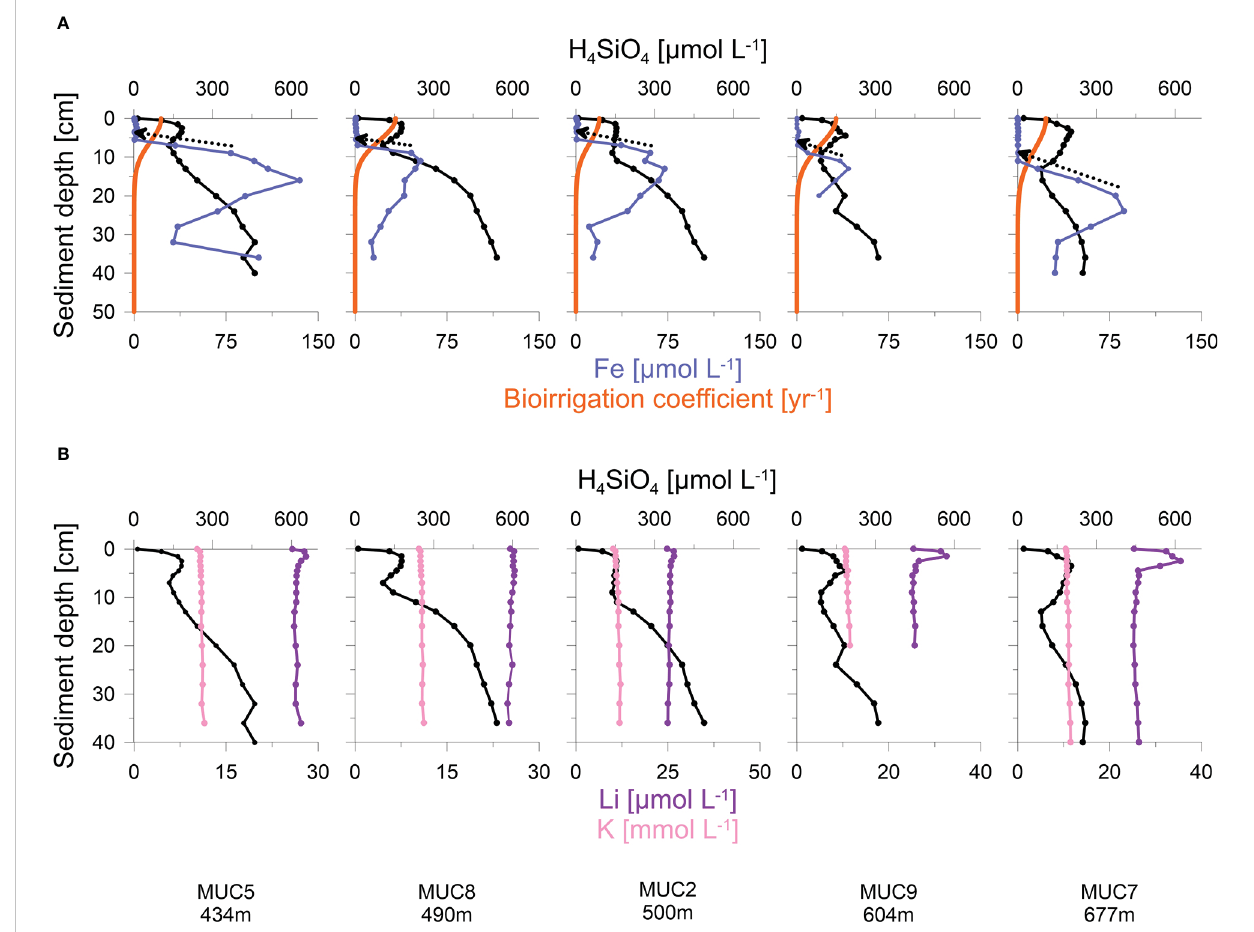
FIGURE 4 (A) Porewater concentrations of H 4 SiO 4 , total dissolved Fe and model simulations of bioirrigation (orange curves). Dashed arrows indicate the gradient used to calculate diffusive Fe fl uxes; and (B) Porewater concentrations of H 4 SiO 4 , K and Li at deep-water stations with distinct H 4 SiO 4 - minima. Note different scales in Li and K concentrations.